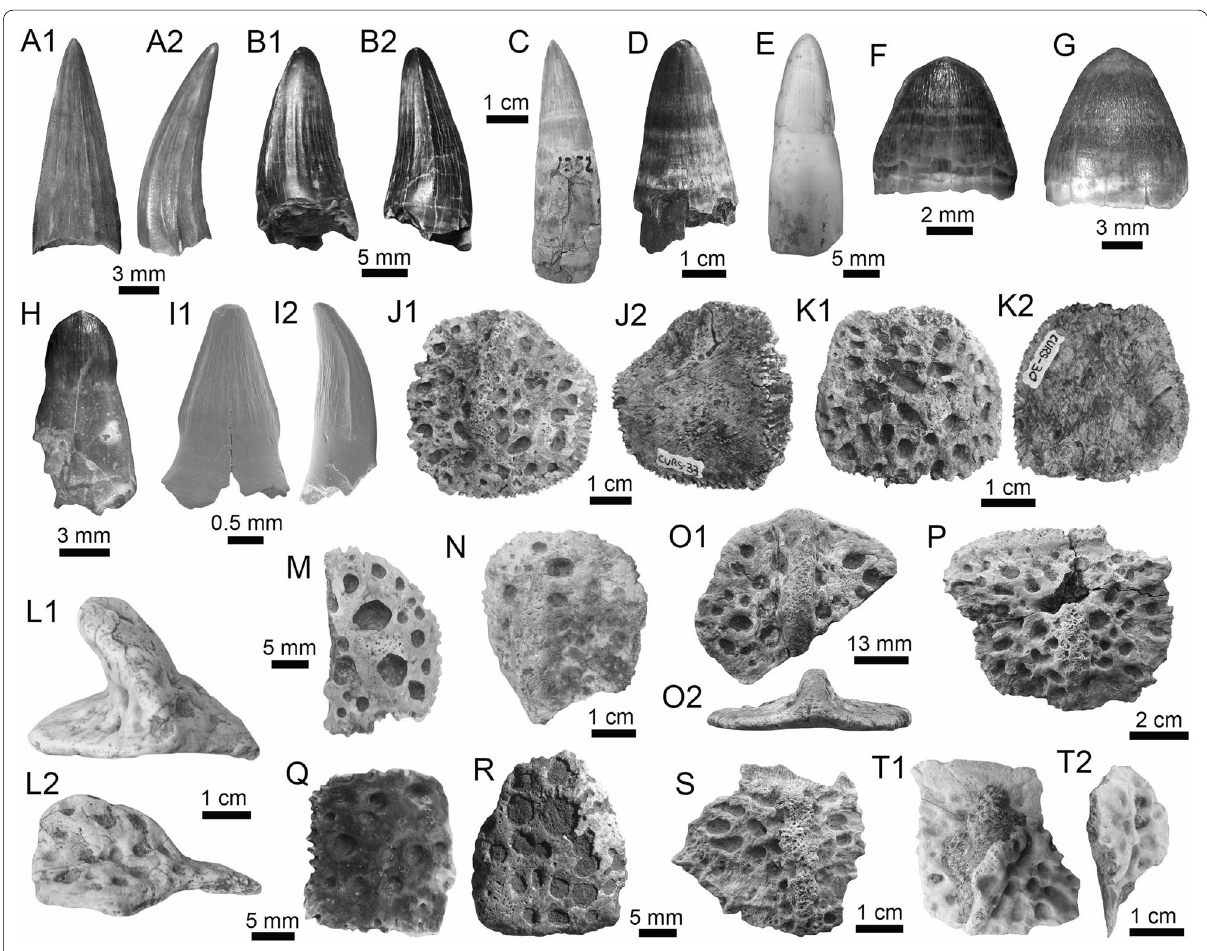
Fig. 20 Crocodylia indet. from the Vergel ( A1 , B2 , D , F – N , P – R ) and Cocuiza ( C , E , O1 , O2 , S – T2 ) members. A1 – I2 Teeth ( A1 , A2 , F – H AMU‑CURS‑861, B1 , B2 AMU‑CURS‑167, C AMU‑CURS‑1352, D AMU‑CURS‑574, E AMU‑CURS‑1322 and I AMU‑CURS‑1095). J1 – T2 Osteoderms ( J1 , J2 AMU‑CURS‑033, K1 , K2 AMU‑CURS‑030, L1 , L2 AMU‑CURS‑593, M , N , Q AMU‑CURS‑594, O1 , O2 AMU‑CURS‑1311, P AMU‑CURS‑1184, R AMU‑CURS‑830, S AMU‑CURS‑1313, and T1 , T2 ‑1312). Views: cross sectional ( L1 , O2 ), external ( J1 , K1 , M – O1 , P – T1 ), internal ( J2 , K2 ), labial ( A1 , C , E – G ), lateral ( A2 , B2 , I2 , L2 , T2 ), and lingual ( B1 , D , H – I1